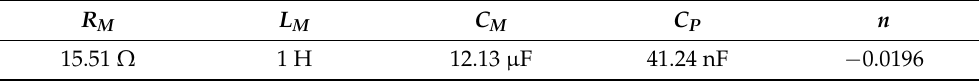
Table 1. Passive component parameters of the bimorph piezoelectric harvester T226-A4-503X. R M L